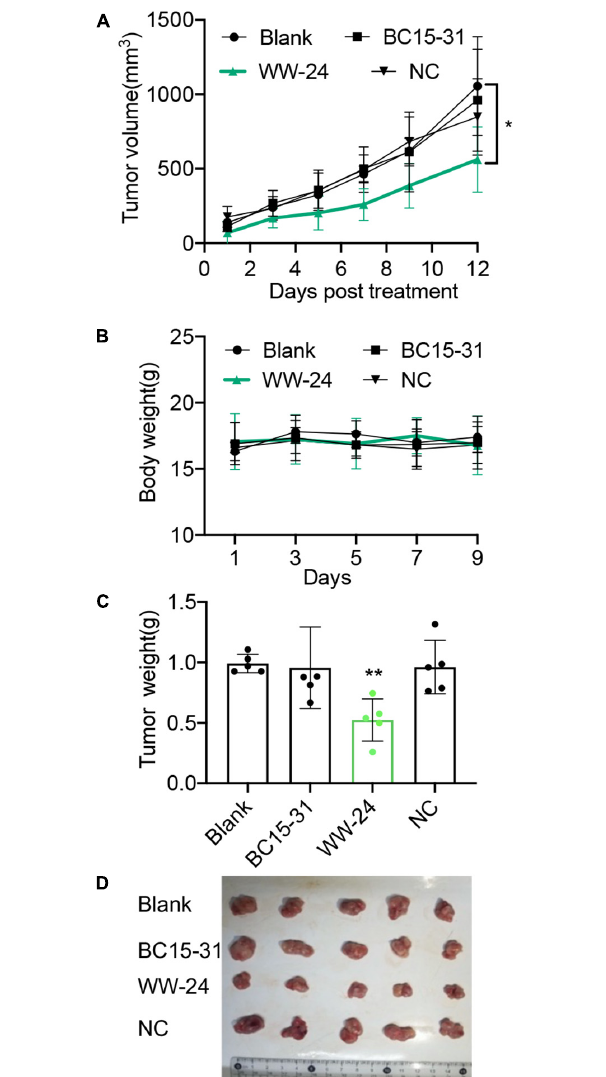
FIGURE 8 | Antitumor efficiency and biosafety of WW-24/Mix nanocomplexes in vivo . A375 cells were inoculated into BALB/c mice. When the tumors had reached 50-80 mm 3 , the mice were treated with GenOpti (blank) or aptamers/Mix by peritumoral injection (2 mg/kg). (A) Tumor volumes were measured and calculated ( n = 5, * P < 0.05). (B) Body weights of mice treated with nanocomplexes ( n = 5). (C) The comparison of each group tumor weight and the bar chart. Statistical analysis was carried out utilizing multiple t -test one per row, and statistical significance was corrected using the Holm-Sidak method for post hoc analysis (A/B) . ** P < 0.01. (D) The picture of each group tumor. All data in this study are average values, and error bars represent standard